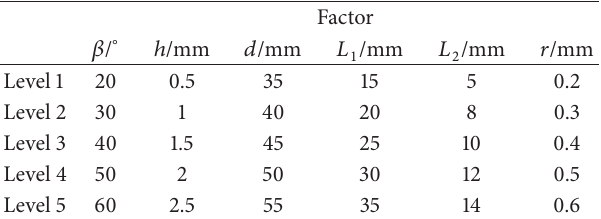
Table 1: Factors and levels.